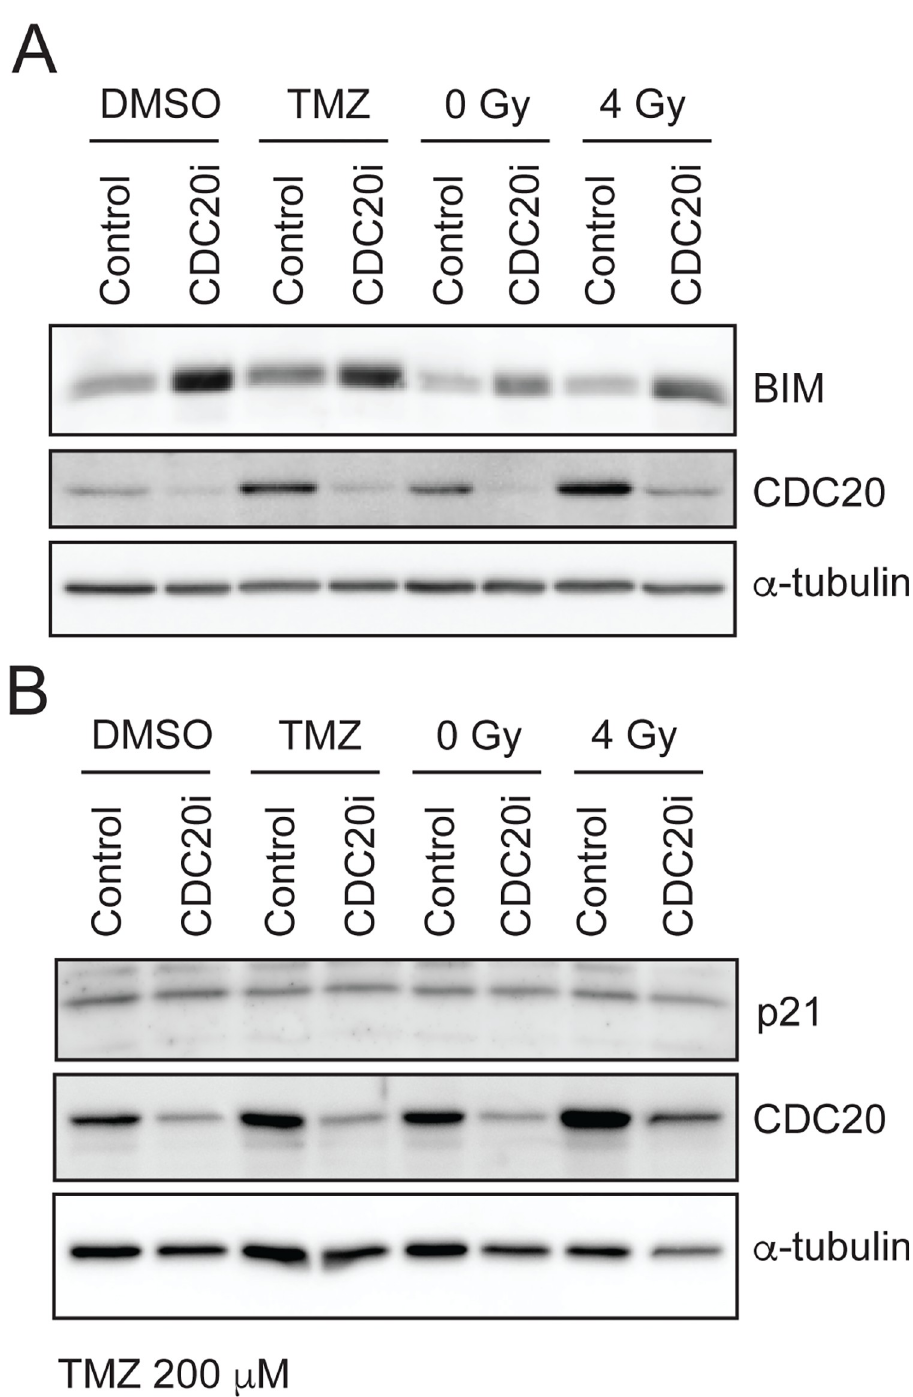
Fig 5. CDC20 inhibition is associated with increased Bim protein in the setting of TMZ and ionizing radiation. (A) B36 GSCs transduced with CDC20 RNAi or a non-targeting control and selected with puromycin were re-plated and then treated the following day with 4 Gy IR or 200 μ M TMZ for 24 hours. Protein lysates were then harvested and analyzed by immunoblotting with the indicated antibodies. (B) B36 GSCs were treated and analyzed as in (A).